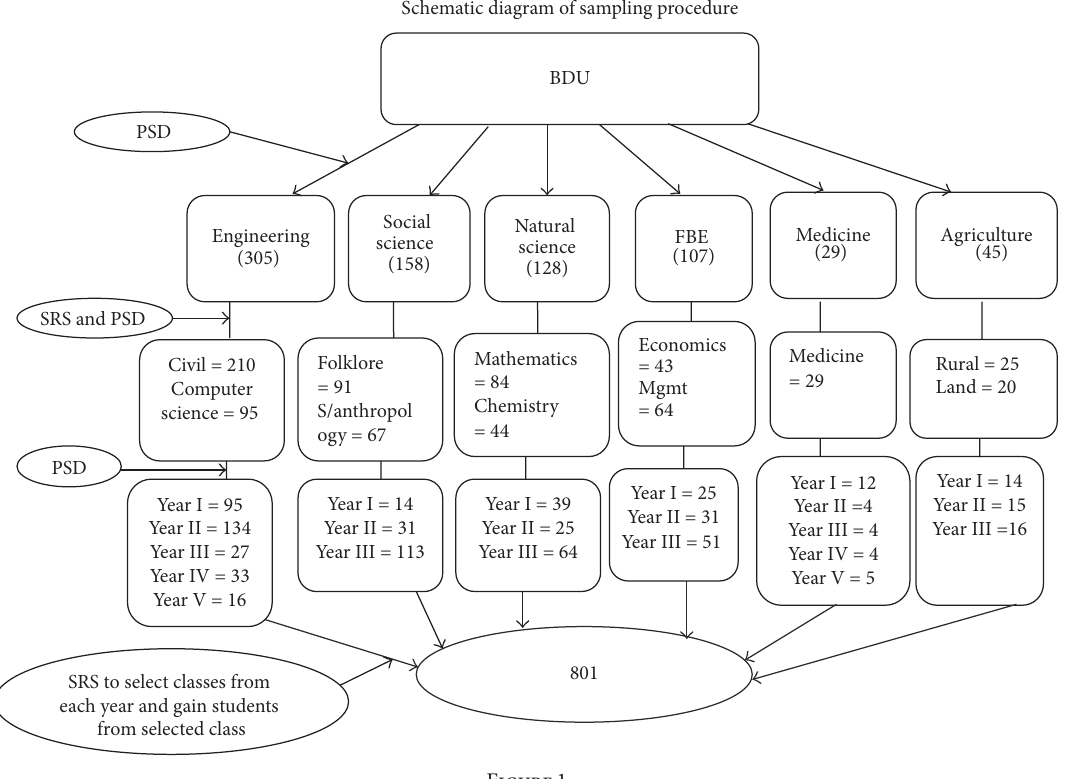
Schematic diagram of sampling